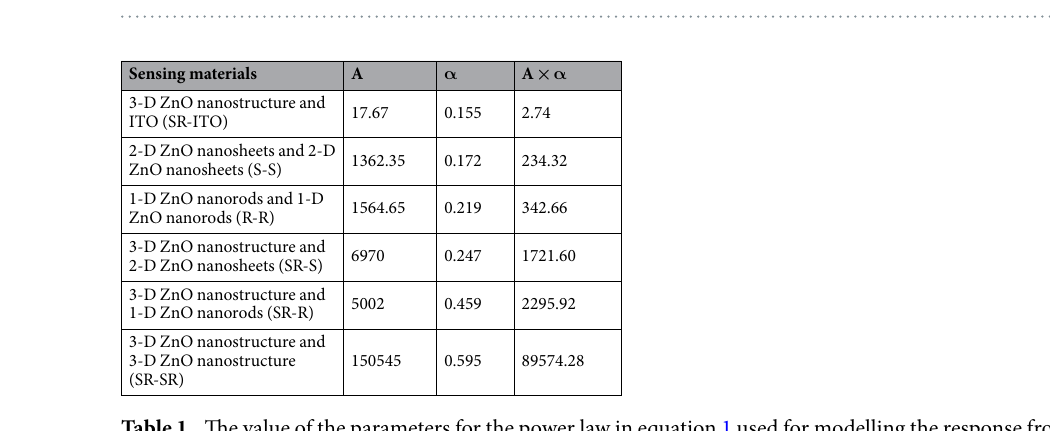
Figure 3. The effect of the structure morphology on the response and sensitivity of the sensor is illustrated for 6 different cases. The response from all the structures can be accurately modelled as a power law function. The lines are the fit from the power law to the data points. ( a ) The SR-SR (hierarchical nanostructure-hierarchical nanostructure) structure has the highest sensitivity due to its hierarchical nature. ( b ) The higher sensitivity in this hierarchical structure results from its greater interaction volume and its variation with pressure compared to just the sheet structure. The response from devices made with the following morphology: ( c ) SR-ITO (hierarchical nanostructure-flat), ( d ) SR-R (hierarchical nanostructure-nanorods), ( e ) SR-S (hierarchical nanostructure-nanosheets), ( f ) S-S (nanosheets-nanosheets) and ( g ) R-R (nanorods-nanorods). ( h ) The sensitivity of all the devices, as calculated from their pressure response, shows a progressive increase with to greater structuring.